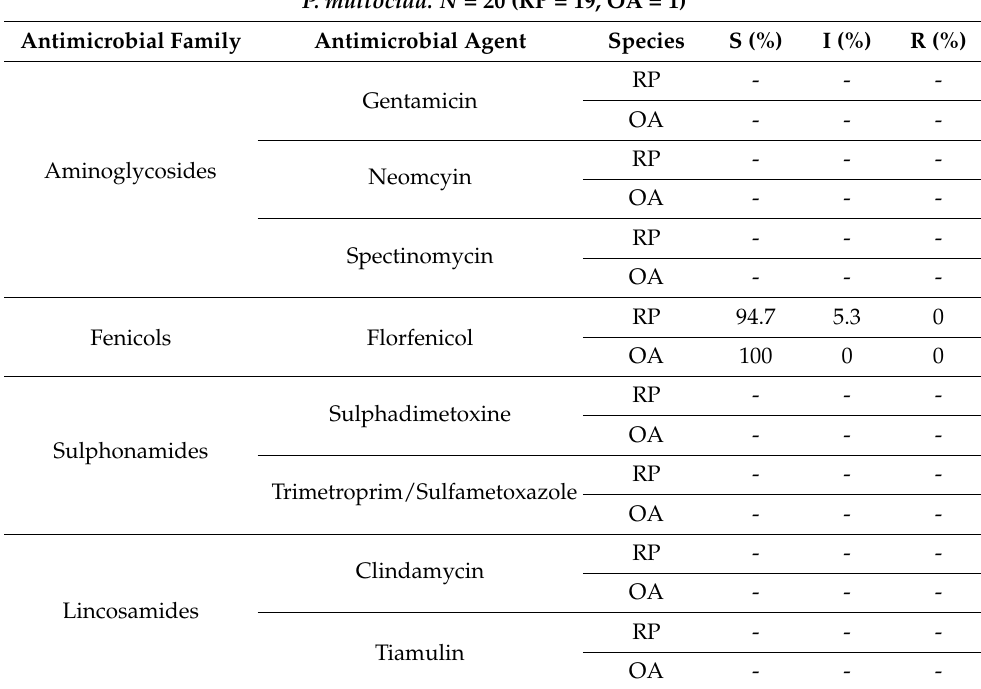
P. multocida. N = 20 (RP = 19, OA = 1)